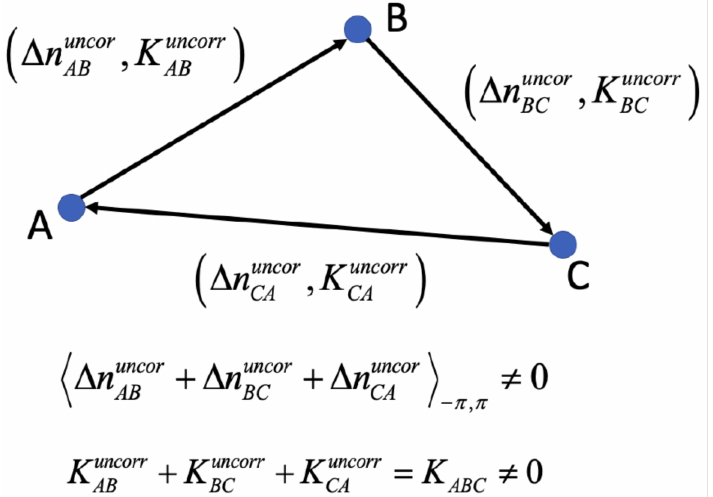
Figure 2. Pictorial representation of the lack of temporal phase consistency among a set of three images A, B, and C. The terms ∆ n uncor and K uncorr are the time-uncorrelated phase alterations and i i the time-uncorrelated phase unwrapping mistakes,